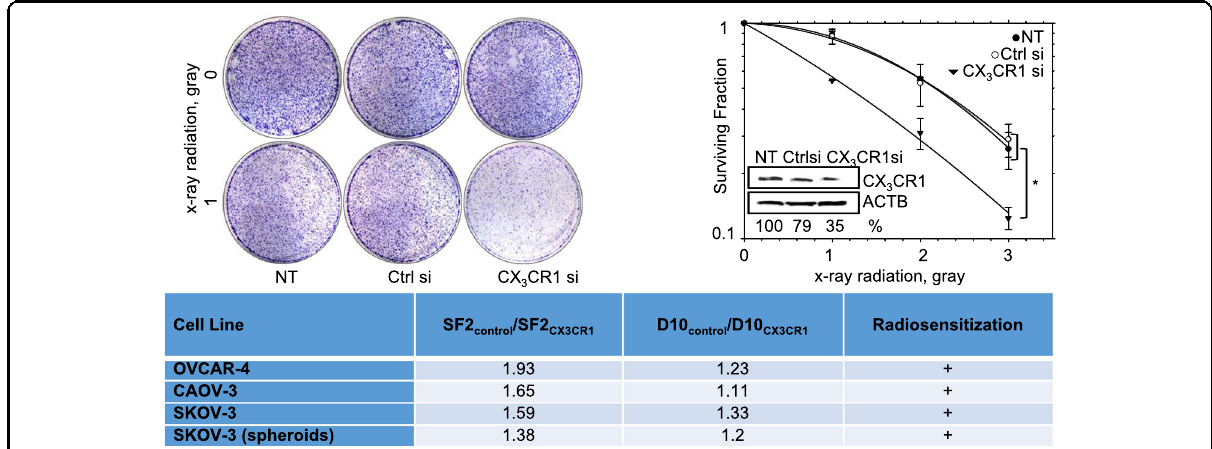
Fig. 2 Downregulation of CX 3 CR1 synergizes with x-ray radiation to reduce clone formation of HGSOC cell lines. OVCAR-4 was transiently transfected with either CX 3 CR1-speci fi c (designated “ CX 3 CR1si ” ) or control (designated “ Ctrl si ” ) si RNAs or vehicle (designated “ NT ” ) and subjected